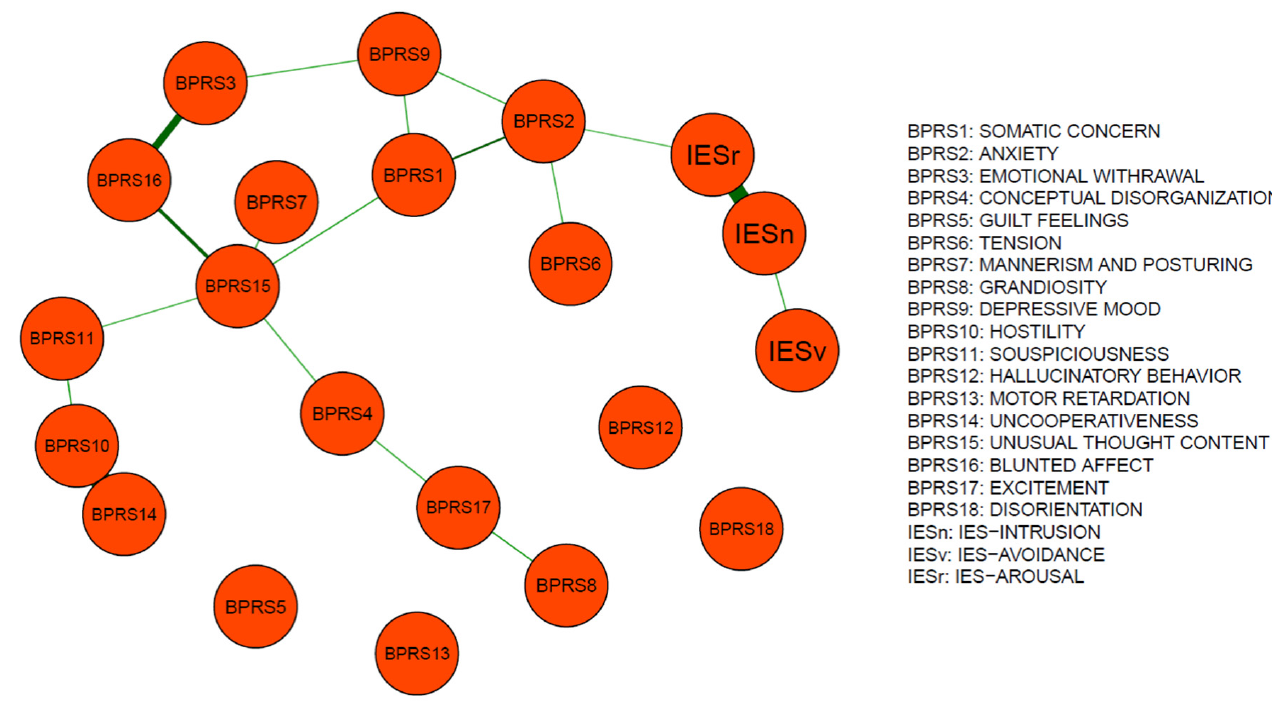
Figure 1. Network structure in the April sample. Edge weights reflect the connection strength of BPRS factors with IES-R dimensions in the April network.